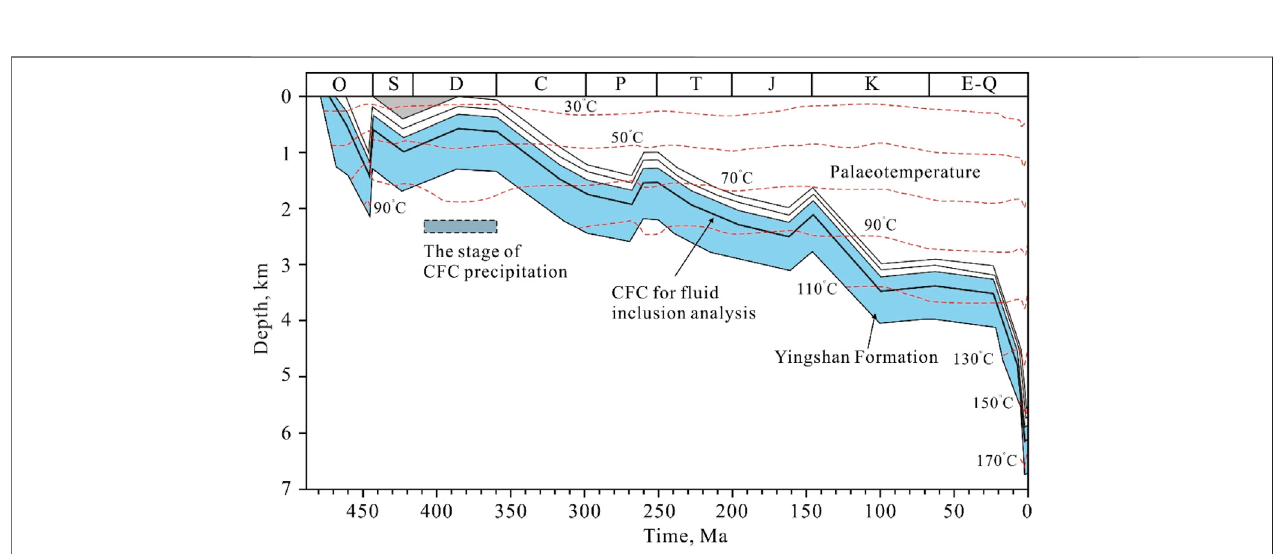
FIGURE 11 | The 1-D burial-thermal history of Well TS3 (from Liu et al., 2017). The blue band represents the Lower – Middle Yingshan Formation. The gray band indicates the Silurian successions.